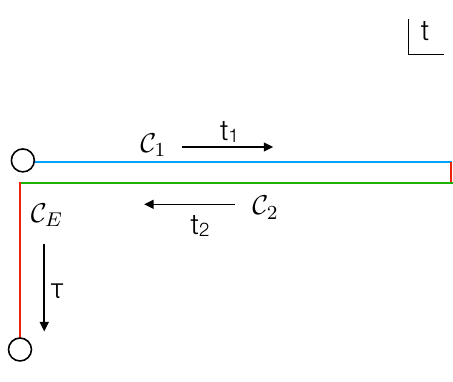
Figure 1 . The Schwinger-Keldysh contour in the complex time plane. It comprises of two Lorentzian segments labelled C 1 and C 2 on which we have sources J 1 ( x ) and J 2 ( x ) , respectively, and a Euclidean part C E on which there is no source. The circles are identified to give a closed path. The associated Euclidean periodicity is the inverse temperature β = 1 /T . For each segment t is parameterised as follows; on C 1 we have t = t 1 with t 1 ∈ [0 , t f ] for some sufficiently large t f > 0 , on C 2 we have t = − t 2 with t 2 ∈ [ − t f , 0] , and on C E we have t = − iτ with τ ∈ [0 , β ]